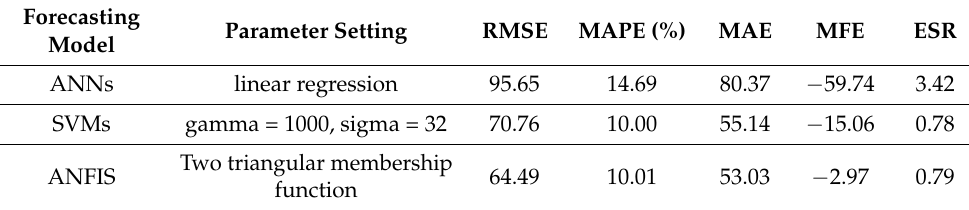
Table 11. Best model prediction accuracy summary.